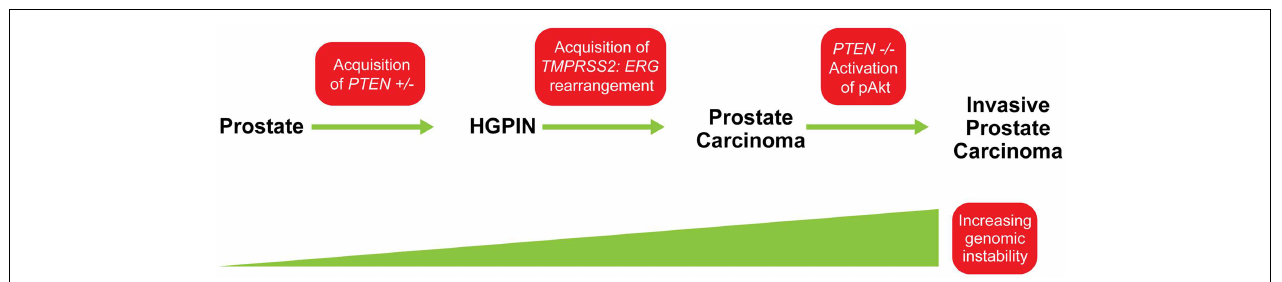
rearrangement, and together, synergistic co-operation between PTEN and ERG abnormalities is associated with early steps of PCA formation. Continuing genetic instability generates “PTEN null” subclones and allows the selective advantage for further tumor progression through activation of the Akt pathway. Modified from